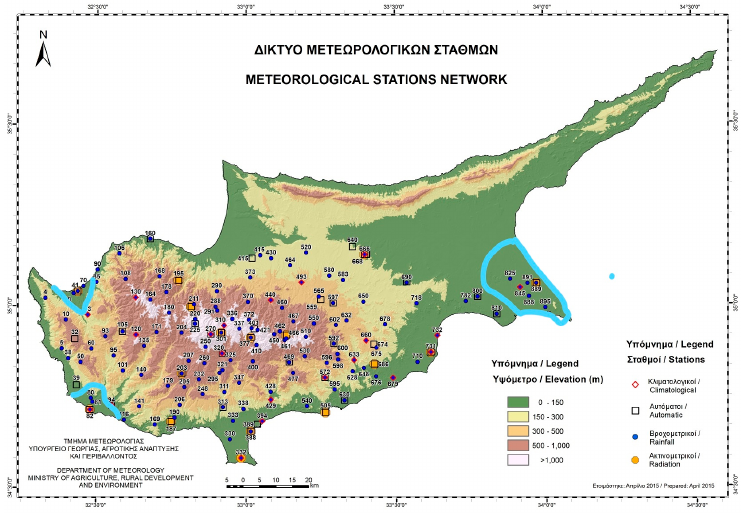
Figure 3. Areas of interest and national meteorological stations used (source: Meteorological Service of Cyprus).